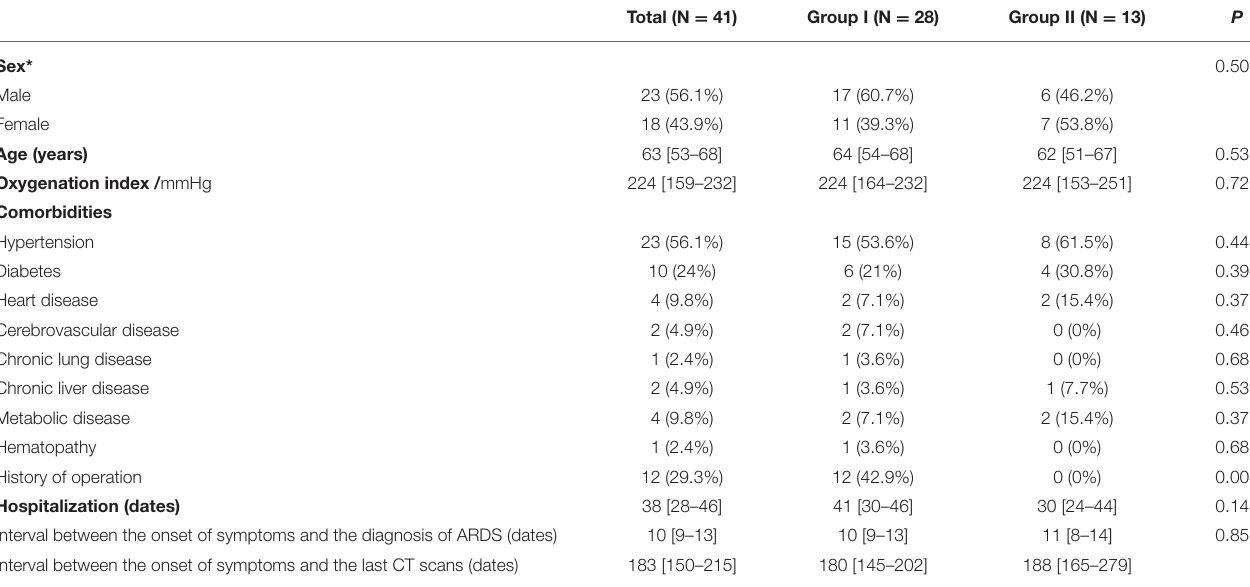
TABLE 1 | Baseline characteristics of all